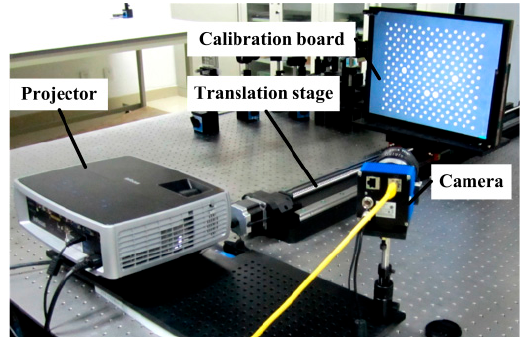
Figure 13. Experimental system.